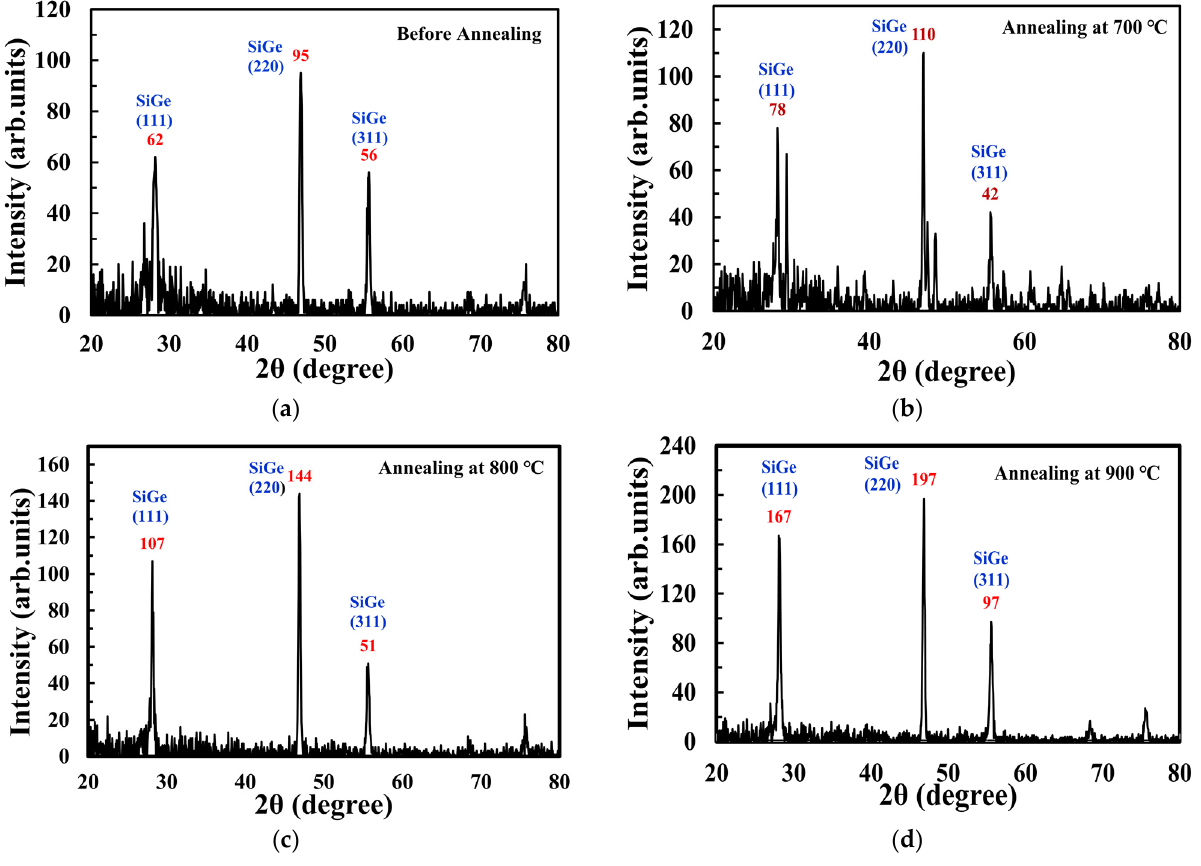
Figure 1. X-ray diffraction pattern of a polySi 0.8 Ge 0.2 film prepared ( a ) without annealing, and at different annealing temperatures of ( b ) 700 °C, ( c ) 800 °C, and ( d ) 900 °C for 30 min.